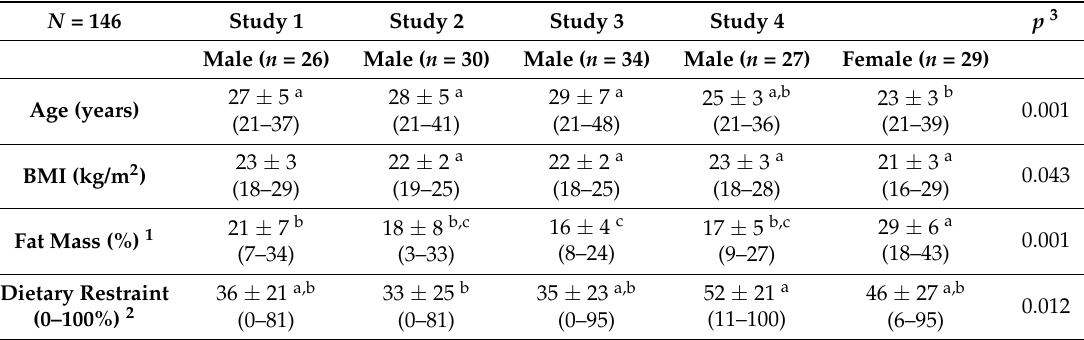
Table 1. Participant characteristics (Mean ± SD and Range) across the